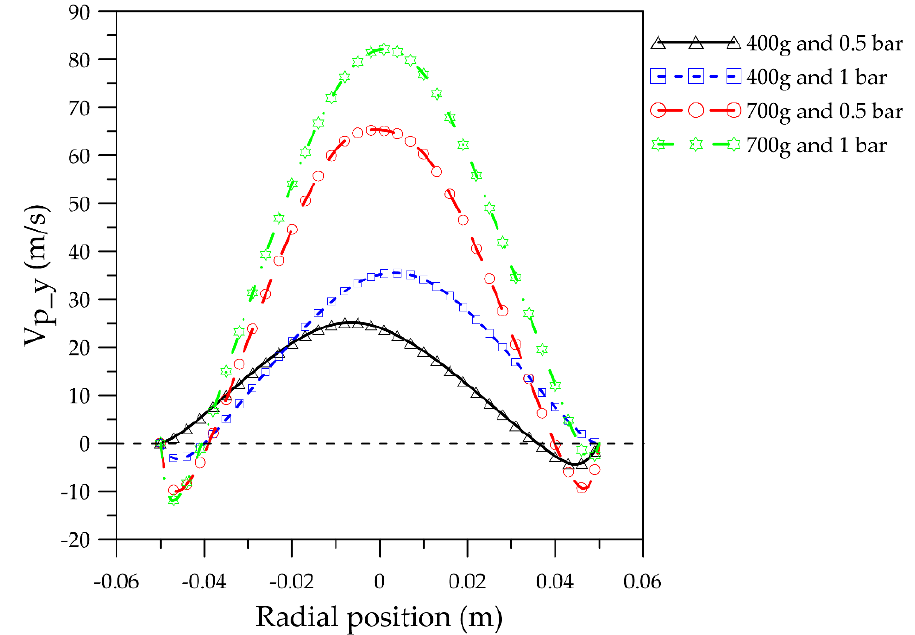
Figure 16. Radial distribution of the time-averaged particle velocity at a fixed axial position of 0.145 m from the equipment bottom (transport region).